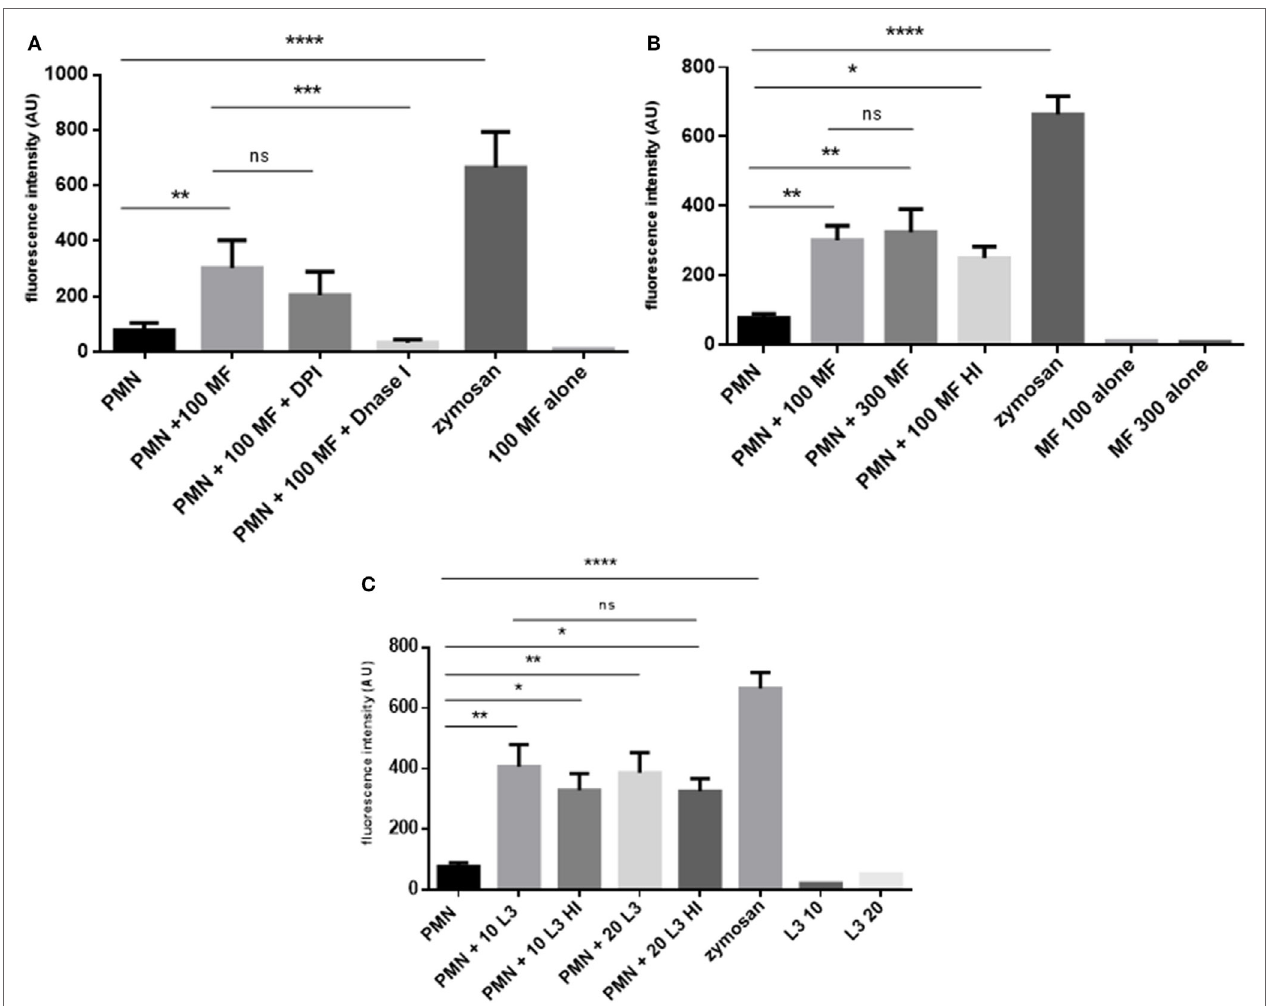
FigUre 3 | Dirofilaria immitis -induced dose- and viability- and diphenyleneiodonium (DPI)-independent neutrophil extracellular trap (NET) formation. (a) D. immitis microfilariae (MF; 100) were cocultured with canine polymorphonuclear neutrophils (PMN) for 180 min. For NADPH oxidase inhibition, DPI pre-treatment was used. To resolve NET formation, DNase I was added to coculture. (B) Canine PMN were cocultured with vital or heat-inactivated microfilariae (MF-HI). (c) Vital and heat-inactivated D. immitis L3 were exposed to canine PMN. Sytox Orange-derived fluorescence intensities were analyzed by spectrofluorometric analysis at an excitation wavelength of 547 nm and emission wavelength 570 nm using an automated plate monochrome reader. As negative control, PMN in plain medium were used. PMN stimulated with zymosan served as positive